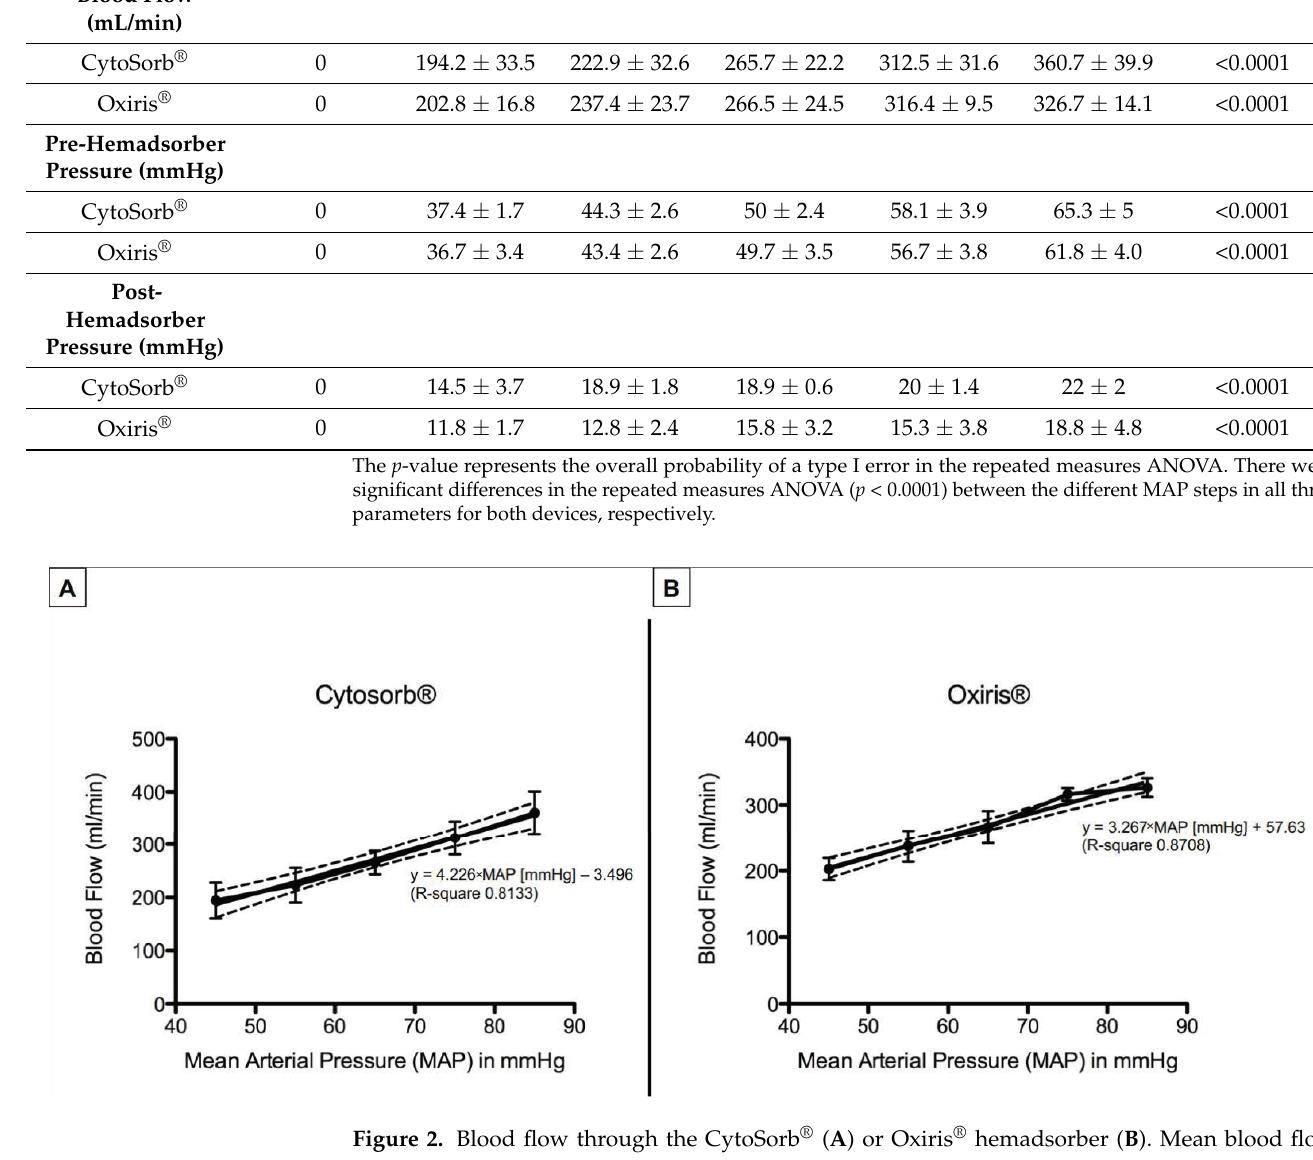
Figure 2. Blood flow through the CytoSorb ® ( A ) or Oxiris ® hemadsorber ( B ). Mean blood flow through both devices linearly increased with stepwise increases in mean arterial pressure. Each figure depicts mean blood flow values ± SD, as well as the linear regression line and their 95% confidence band of the best-fit line (scattered lines).